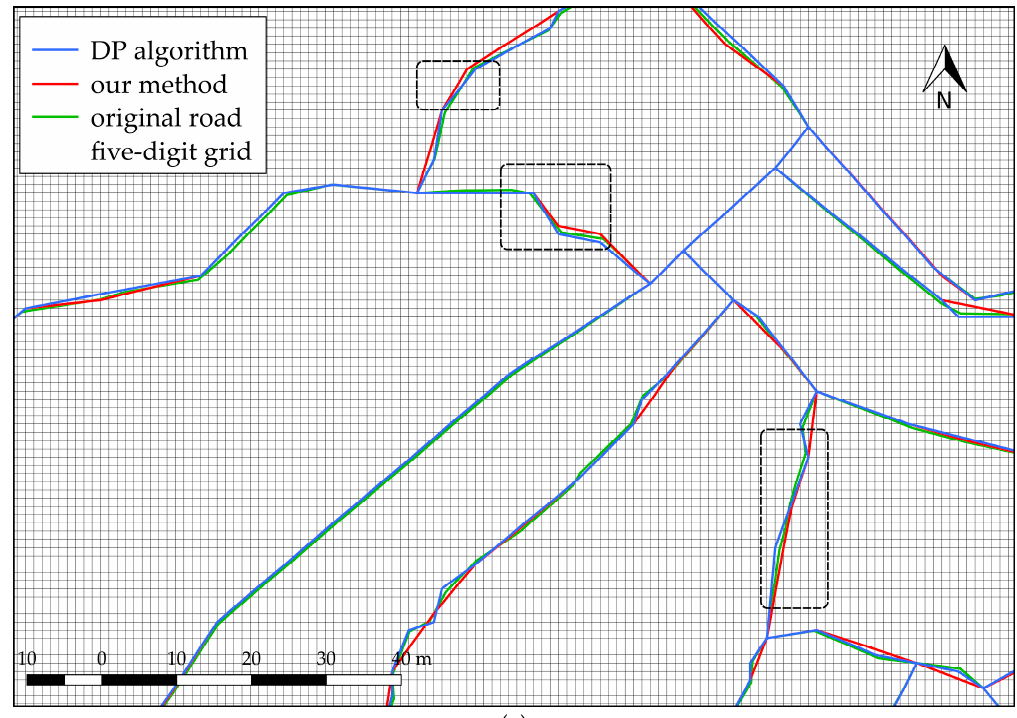
Figure 15. Seven-digit original road network data of a region in Chongqing, China. The region in red box 1 is shown in Figure 16, and the region in red box 2 is shown in Figure 17.